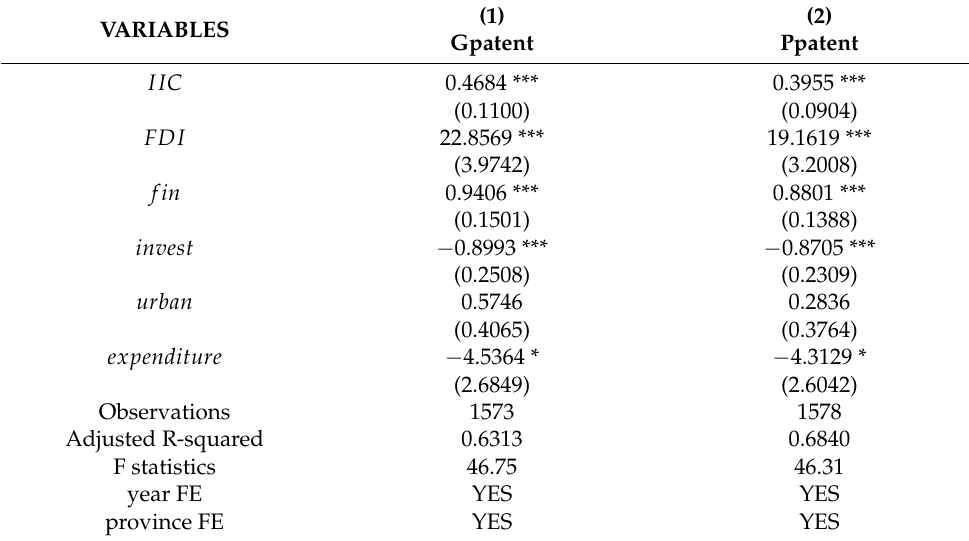
Table 9. Mechanism test: technological innovation